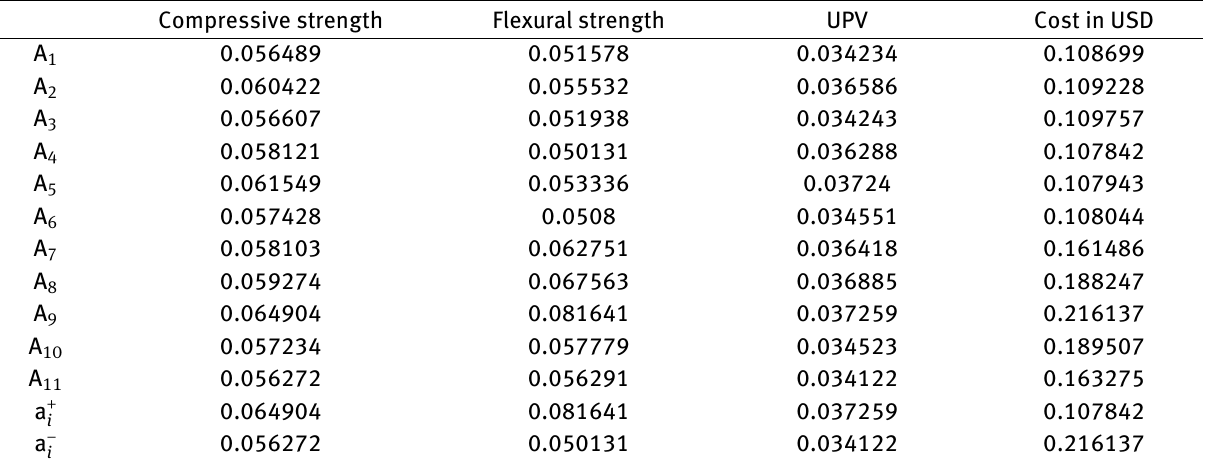
Table 18: The weight normalized decision matrix ( B ) and the positive and negative ideal reference point obtained from TOPSIS method. Compressive strength Flexural strength